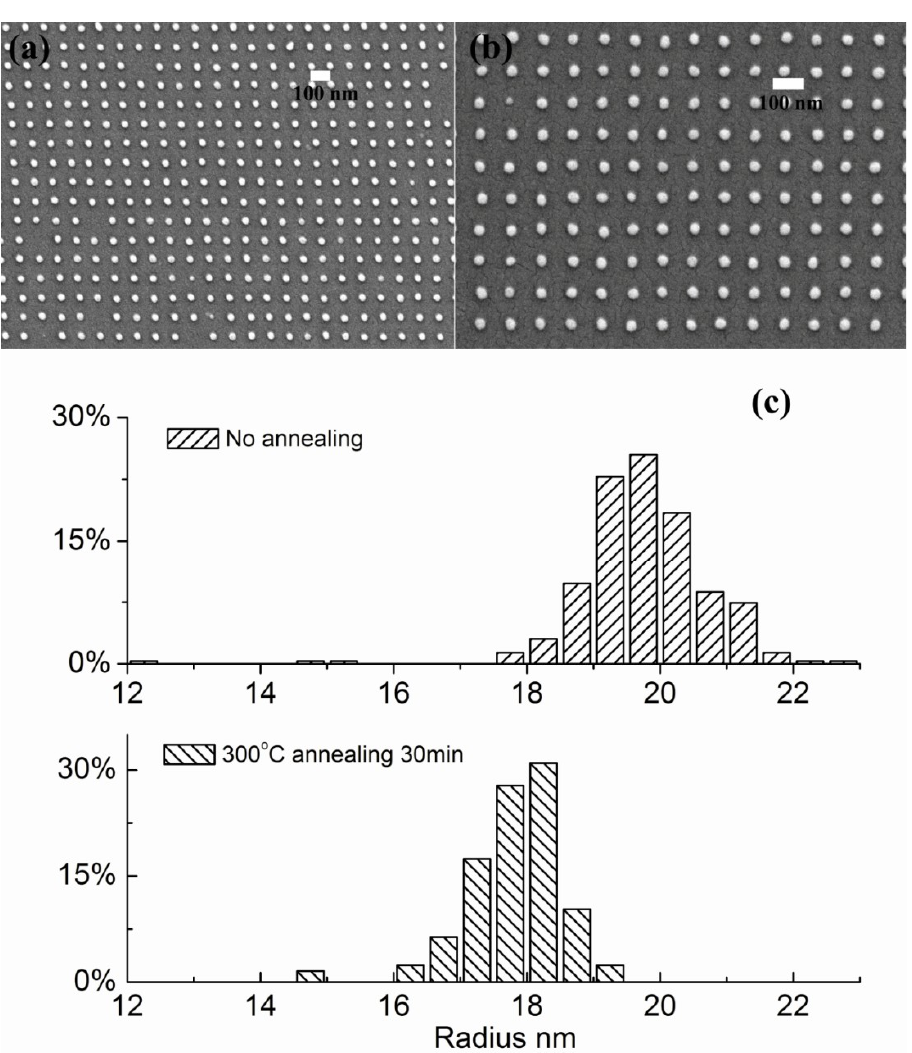
Figure 2. The SEM images of the polycarbonate pillars ( a ) before and ( b ) after thermal annealing, and ( c ) the distribution of the radius of the polycarbonate pillars before and after thermal annealing.